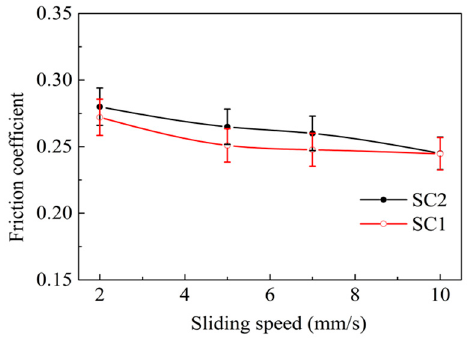
Materials 2018 , 11 , x FOR PEER REVIEW Figure 4. Friction coefficient of the sliding couple at different speeds (load = 50 N).